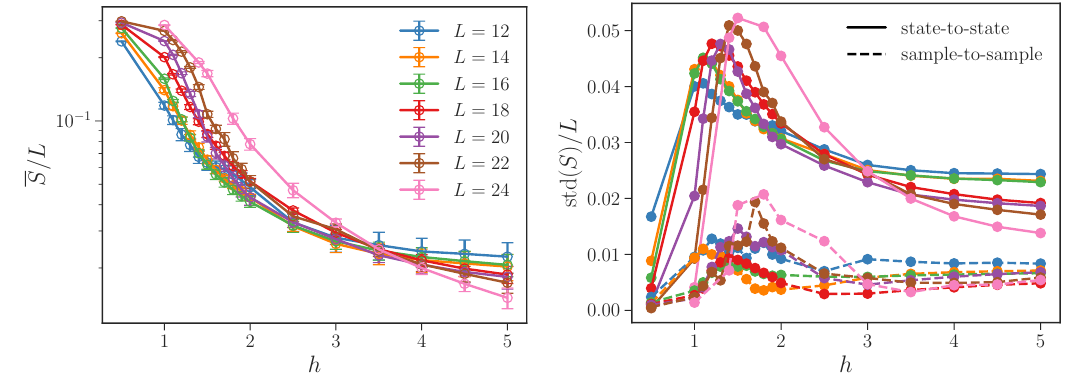
Figure 3: Left: Average half-chain entanglement entropy divided by system size, as a function of potential strength, for various system sizes. Right: Eigenstate-to- eigenstate (solid lines) and sample-to-sample (dashed lines) standard deviation of the entanglement entropy, divided by system size. Color coding for system size is the same in both